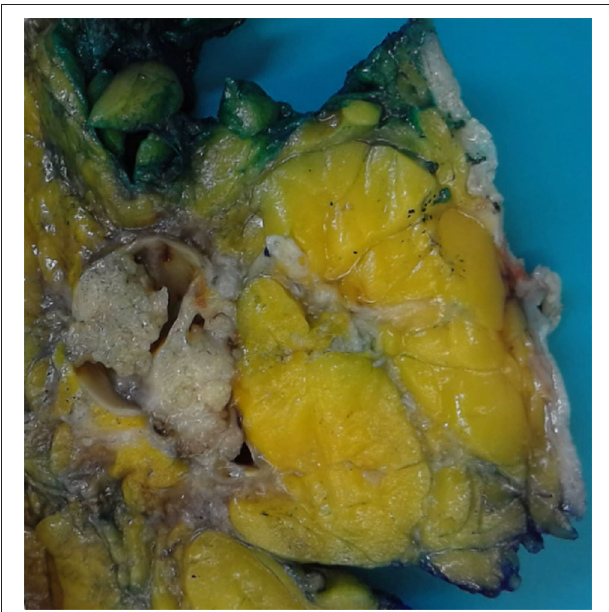
FIGURE 3 | Gross pathology of the specimen shows solid mural nodules and cystic spaces surrounded by a fibrous capsule.